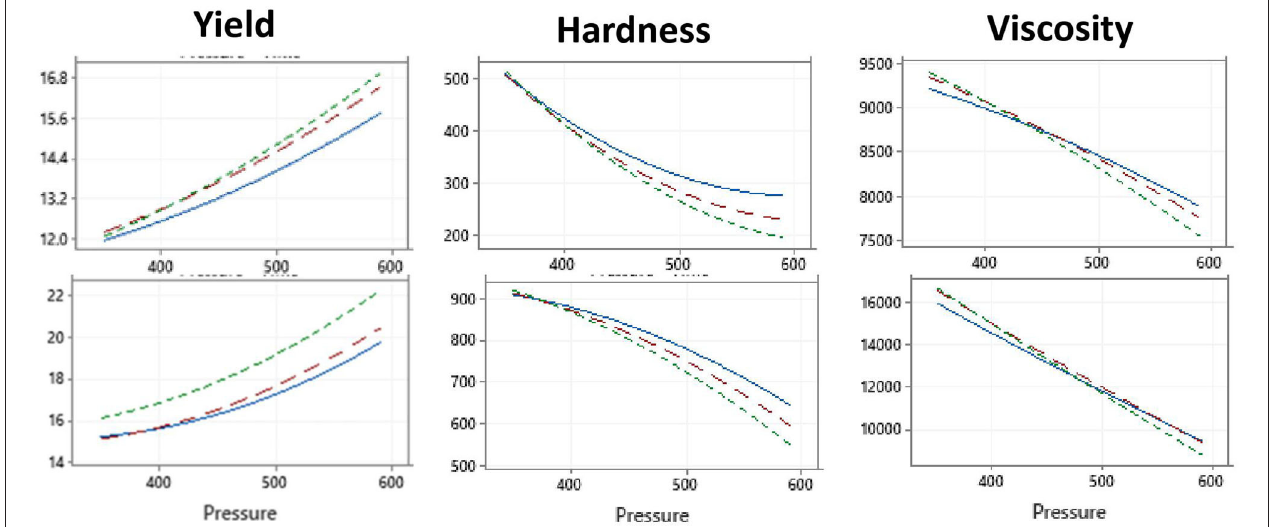
FIGURE 1 | Effect of HPP pressure and time at 4 ◦ C on the yield, hardness, and viscosity of camel (Upper panel) and bovine (lower panel) cheeses. Treatment time: 1min (blue lines), 5min (red lines), and 10min (green lines). The illustration shows the effect of pressure—on the yield, hardness, and viscosity at three different times at (1, 5, and